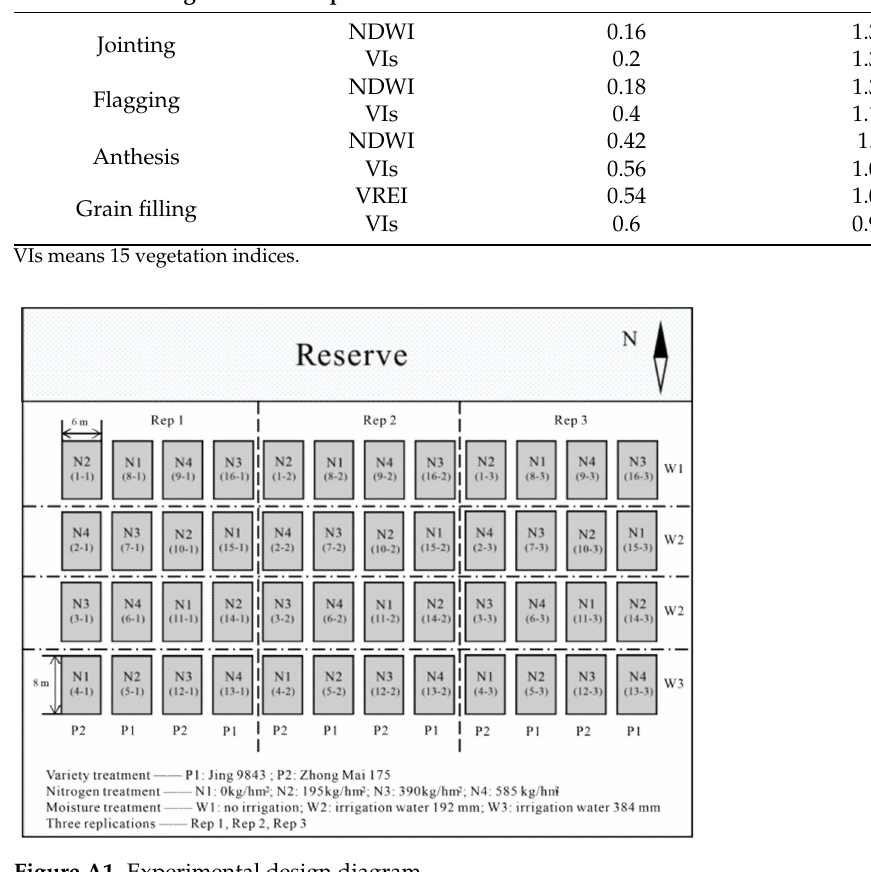
Figure A1. Experimental design